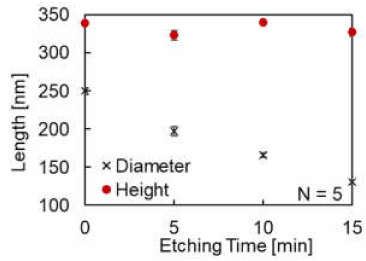
Figure 4. Diameter and height of nanopillars of re-shaped COP molds for each etching time. The red dots indicate height, and the black crosses indicate